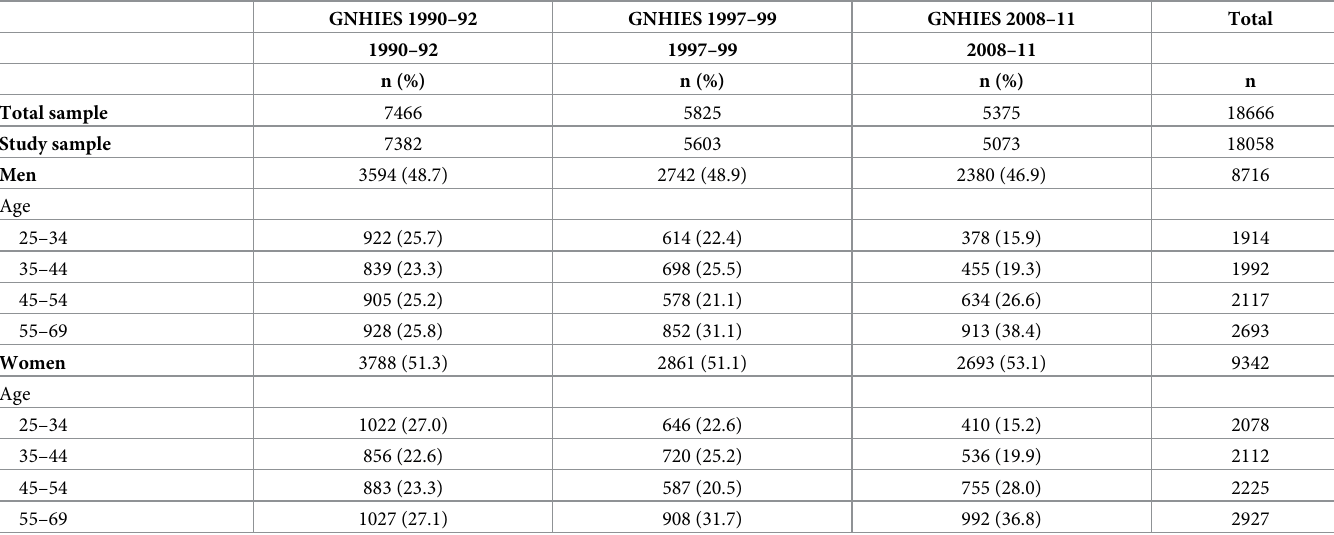
Table 1. Distribution of the study samples according to sex and